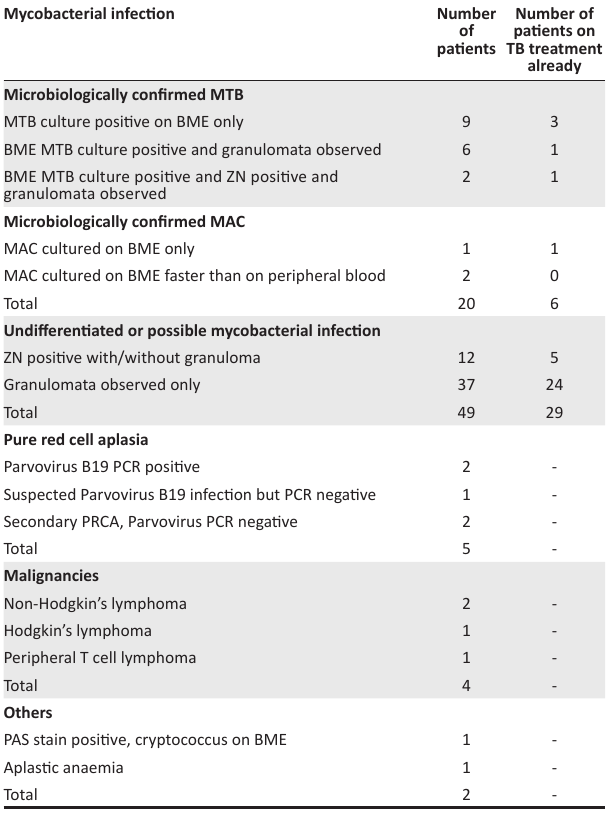
TABLE 2: Unique diagnoses on bone marrow